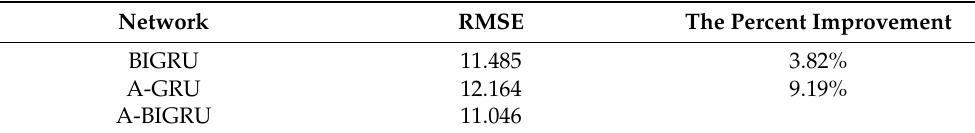
Table 8. Comparison results of bidirectional network and attention mechanisms.